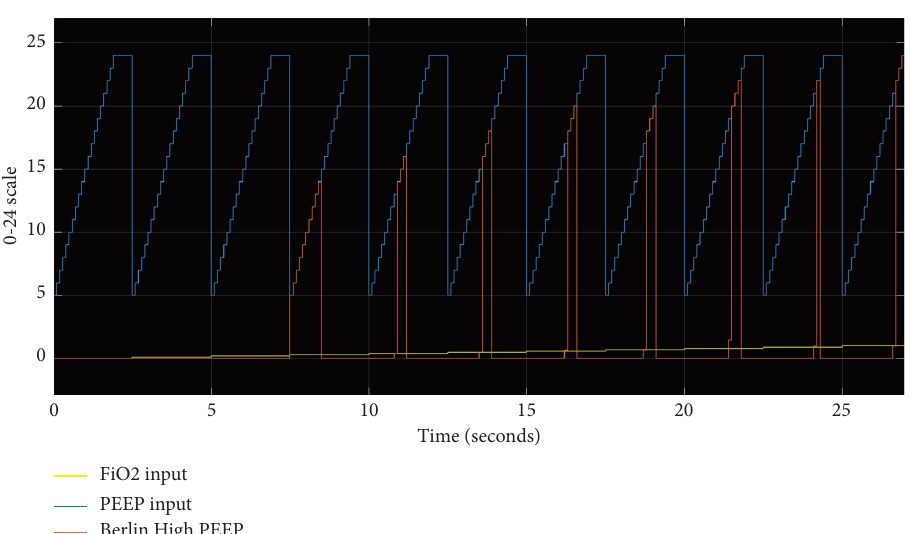
Figure 14: Graph showing the relationship between the two input parameters: FiO colour), with the fuzzifed Berlin high PEEP output (red in